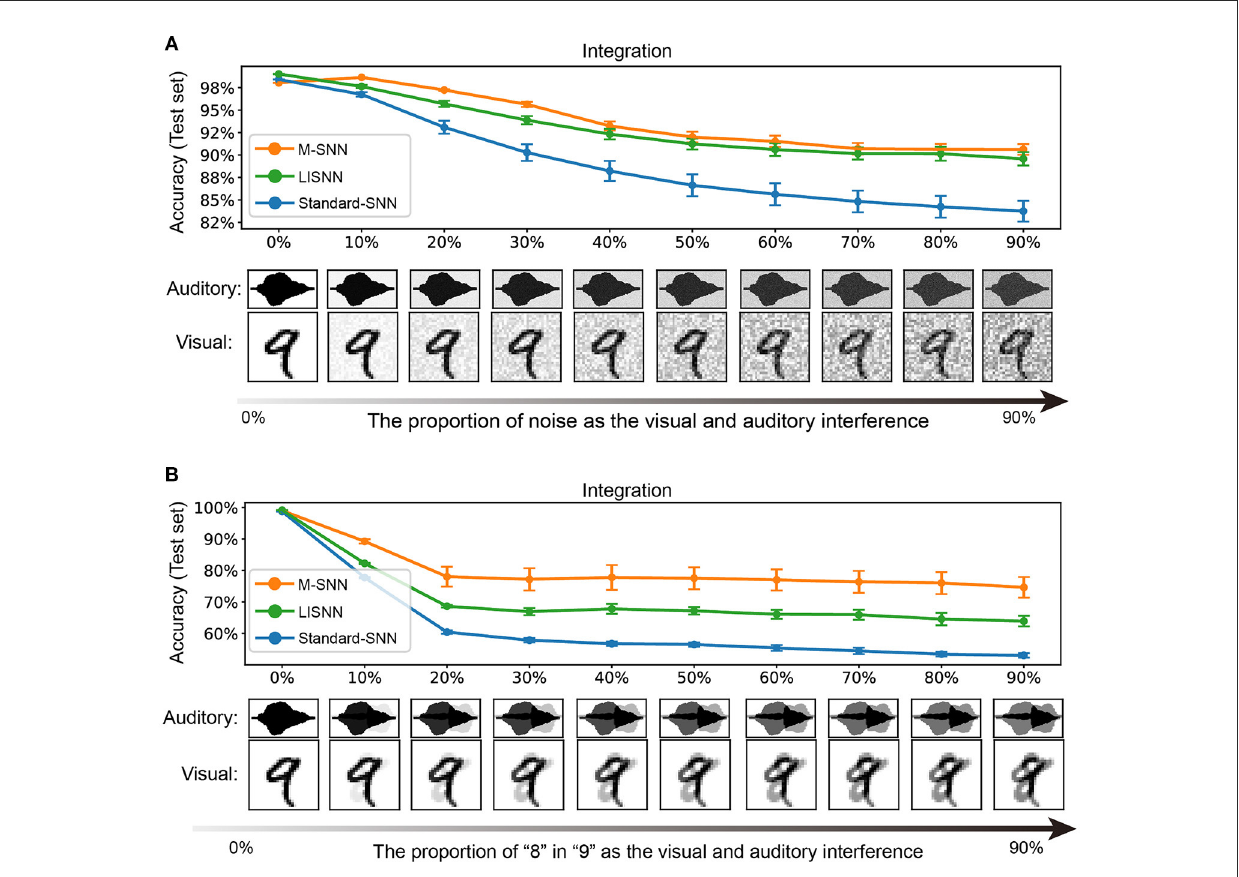
FIGURE4 Simulation of cocktail party effect. (A) A simulation and results in which both visual and auditory inputs have interfered. (B) A simulation and results in which only the voice has interfered. All figures are averaged over five repeating experiments with different random seeds.